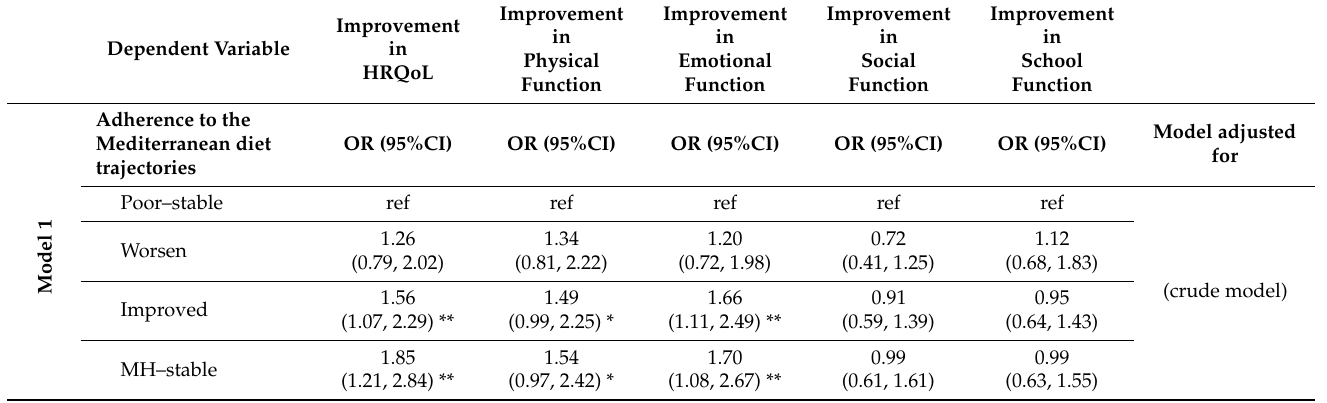
Table 5. Logistic regression models evaluating the association between trajectories in the level of adherence to the Mediterranean diet and the odds of parent-perceived quality-of-life improvement of students during the follow-up